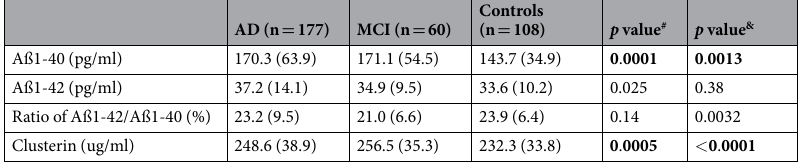
Table 2. Plasma biomarkers for the whole sample and patients with AD, MCI and controls. Values are means with standard deviations unless otherwise indicated. AD, Alzheimer’s dementia; MCI, mild cognitive impairment; Aß, amyloid ß peptide. # Compare AD and controls by two-sample t-tests; $ compare MCI and controls by two-sample t-tests.